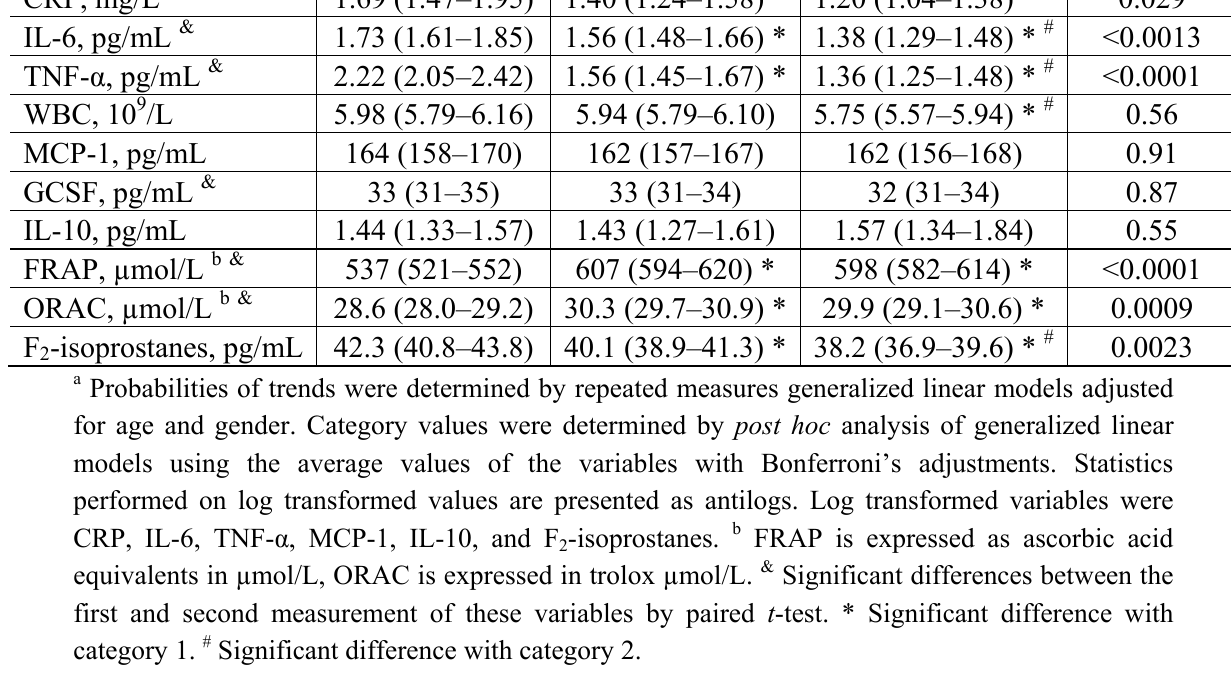
Table 4. Outcome characteristics (least square means (95% confidence interval)) by category of combined fruit and vegetable intake category in a community